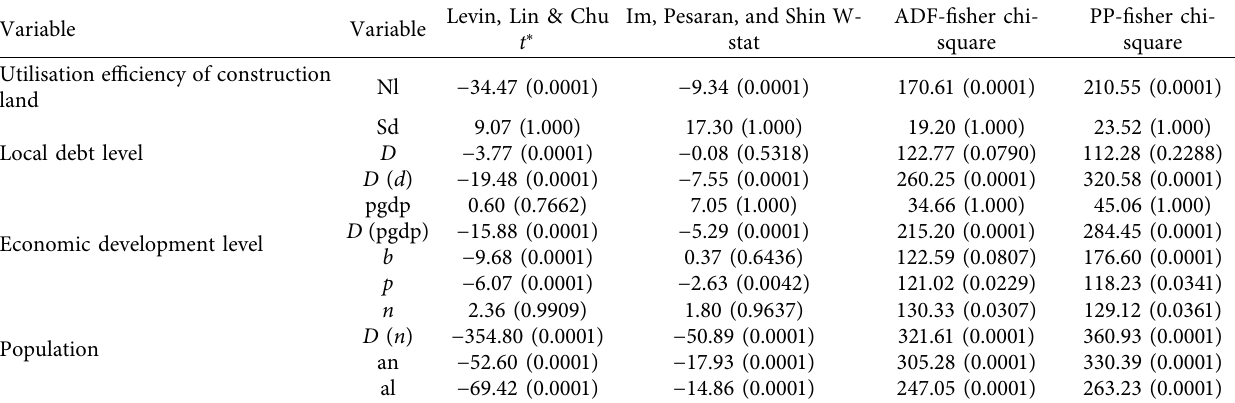
Table 1: Unit root test results.